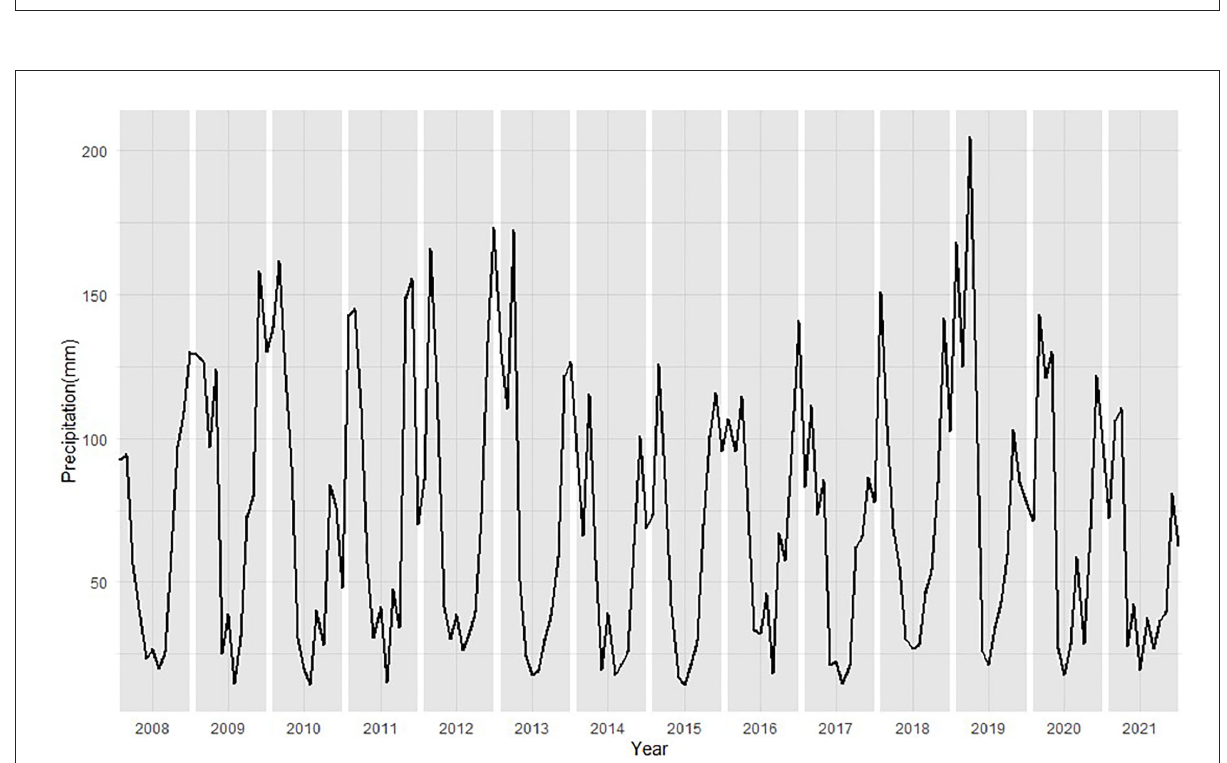
FIGURE7 Monthly CHIRPS data spatially averaged across three northern provinces (Mazandaran, Gilan and Golestan) as the areas of interest in Iran from 2008 to 2021 for northern